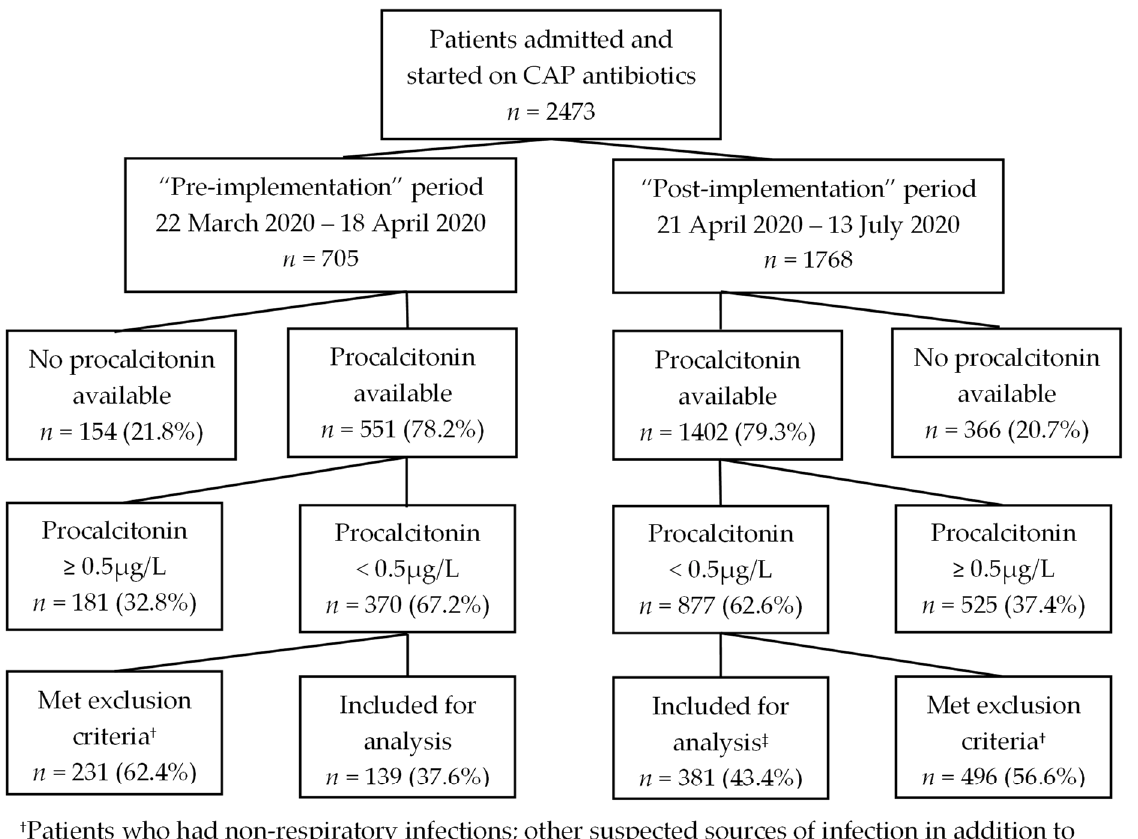
Figure 1. Patients with community-acquired respiratory infections admitted to the respiratory sur- veillance wards were screened for suitability for stewardship audits . Abbreviations: CAP, commu- nity-acquired pneumonia; CA-ARI, community-acquired acute respiratory